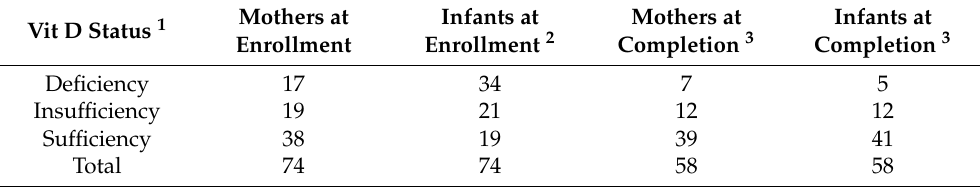
Table 1. Vitamin D status of study subjects at enrollment and completion.